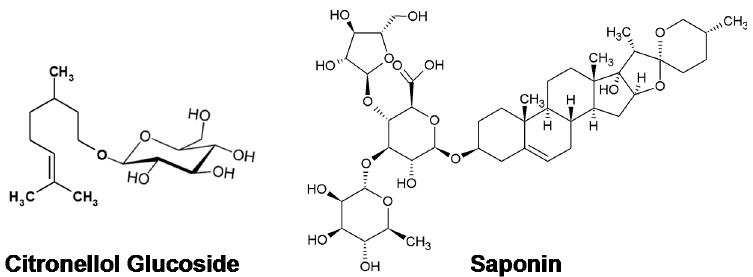
Figure 1. Natural surfactants investigated in the study.